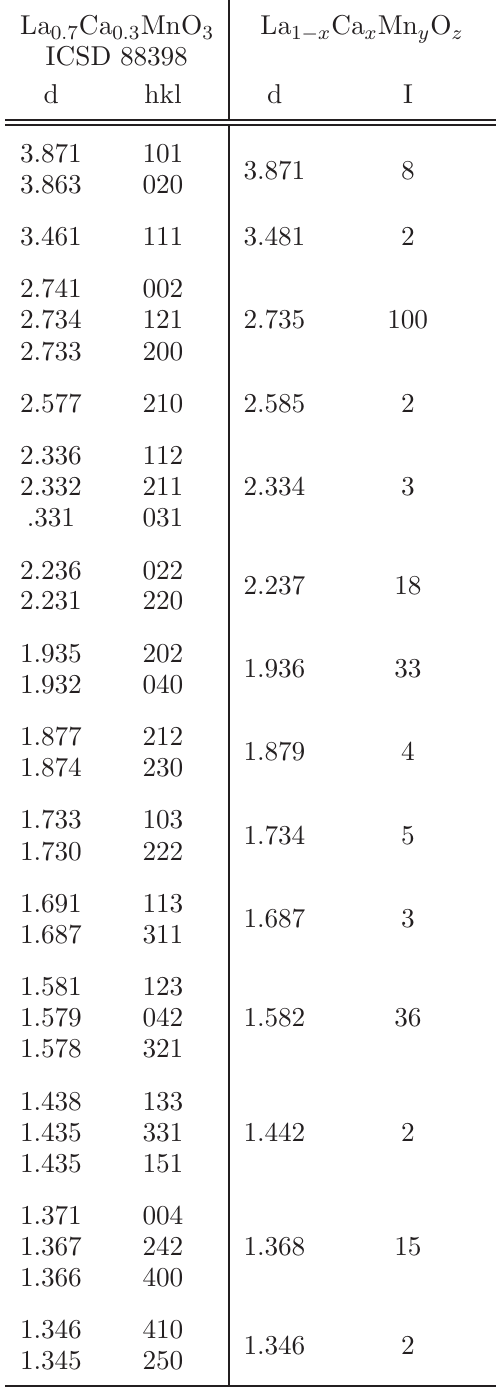
Table 4 Interplanar distances (d, ˚A), relative intensities (I, %) and Miller indexes in La 1 − x Ca x Mn y O z , obtained by heating the LaCaMn - citrate at 450 ◦ C (1 h) and 1200 ◦ C (2